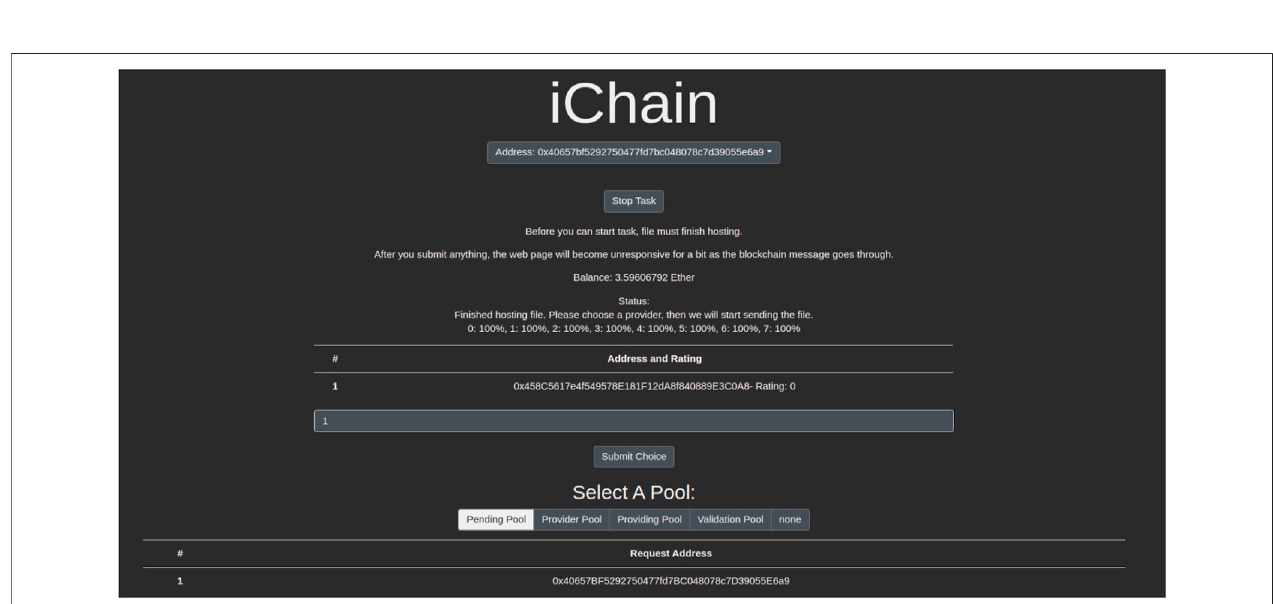
FIGURE 7 | User web application